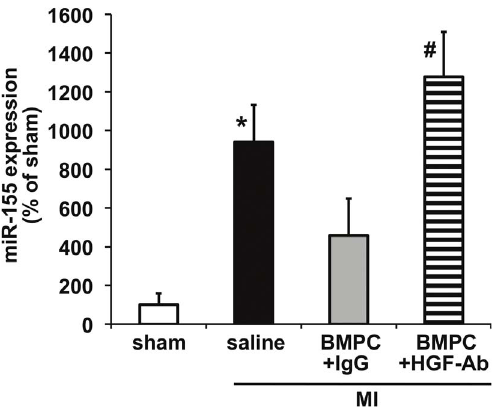
Figure 3. Expression of miR-155 in infarcted hearts (day 3) of db/db mice receiving BMPC intramyocardial. BMPC therapy marginally (although not significantly) decreased MI-induced miR-155 expression (measured by qRT-PCR) in comparison with saline-treated group. Administration of neutralizing antibodies against HGF (HGF-Ab) significantly elevated miR-155 levels as compared to IgG treated group. * P , 0.05 versus sham; # P , 0.01 versus IgG treated mice. HGF-Ab indicates antibodies against hepatocyte growth factor; Col1A1, collagen type 1 alpha 1; Col1A1, collagen type 3 alpha 1; a -SMA, alpha smooth muscle actin; BMPC, bone marrow-derived progenitor cell. BMPC,